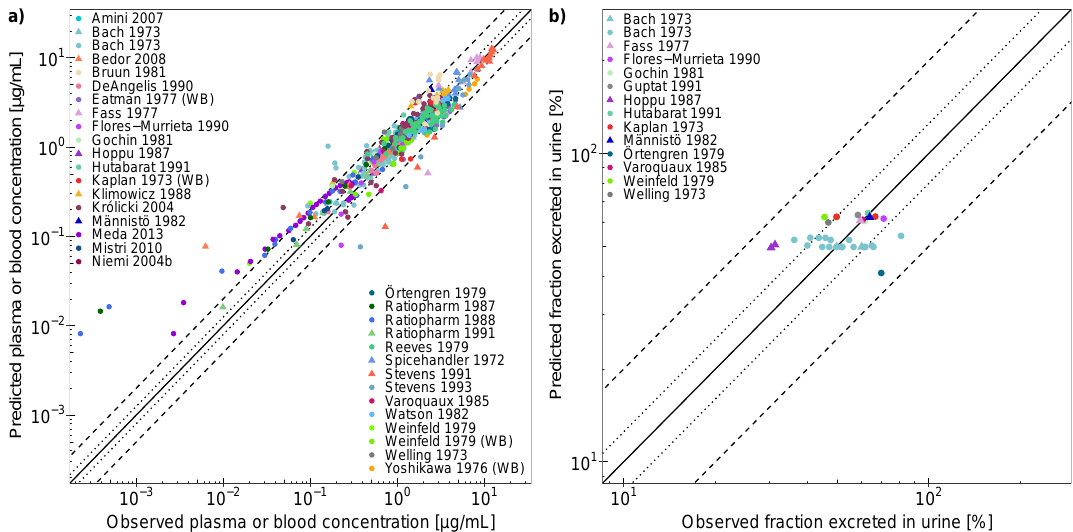
Figure 3. Trimethoprim physiologically-based pharmacokinetic (PBPK) model performance. The goodness- of-fit plots show predicted compared to observed ( a ) plasma or whole blood concentrations and ( b ) fractions excreted unchanged in urine of all studies used for model building and evaluation. Thesolidlinemarksthelineofidentityanddottedlinesindicate1.25-foldanddashedlinesindicate2-fold deviation. Dataareshownastriangles(trainingdataset)ordots(testdataset)[30,31,33,37,41,43,46,51–73]. Details on the predicted clinical studies and the individual fraction excreted unchanged in urine values are provided in the Supplementary Materials. WB, whole blood.